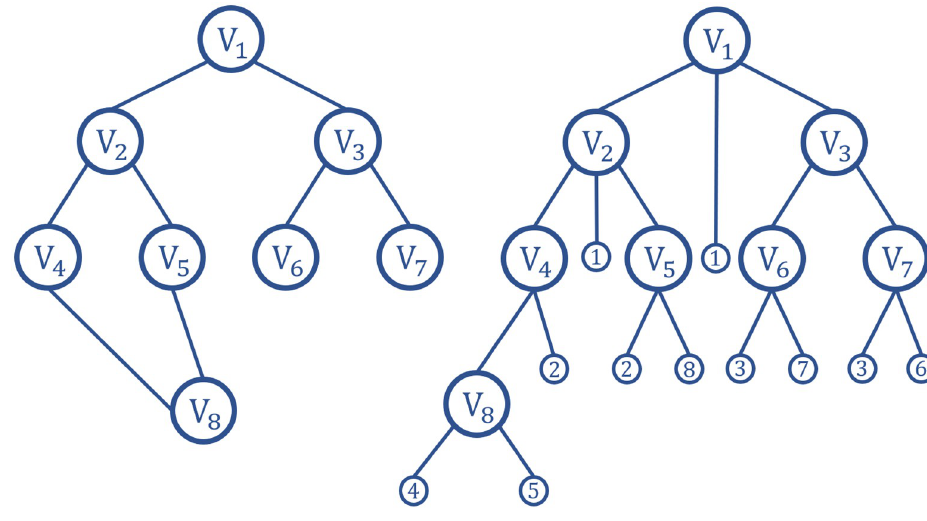
Fig 2. The process of